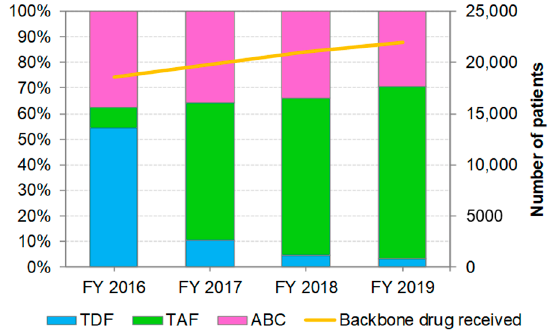
Figure 1. Changes in backbone drug prescriptions from FY 2016 to FY 2019. The yellow line indicates the number of patients estimated by the prescription volume of TDF, TAF, and ABC. The analysis was performed on drugs listed in Table 1. TDF: tenofovir disoproxil fumarate, TAF: tenofovir alafenamide fumarate, ABC: abacavir.